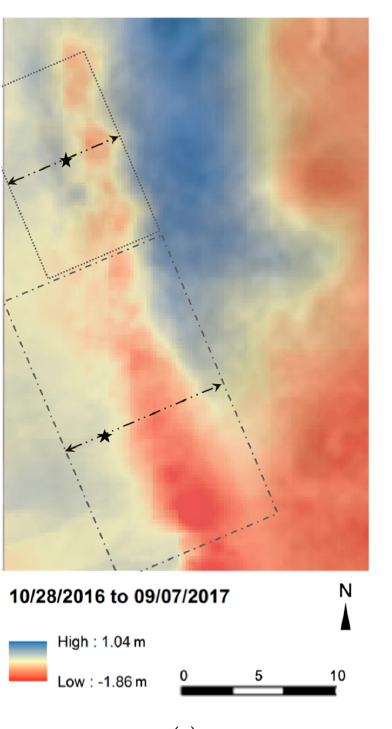
Figure 5. Normalized (according to the initial, 10 / 28 / 16, survey) volumetric change of the natural and mechanical dunes (left axis; solid lines) where values < 1 and > 1 indicate dune erosion and accretion, respectively. The standardized area values are calculated according to the 10 / 28 / 16 survey where values < 1 indicate there is a reduction of initial dune area (right axis; dashed lines). The standardized area is presented because the dune area fluctuated each survey. J. Mar. Sci. Eng. 2019 , 7 , x FOR PEER REVIEW